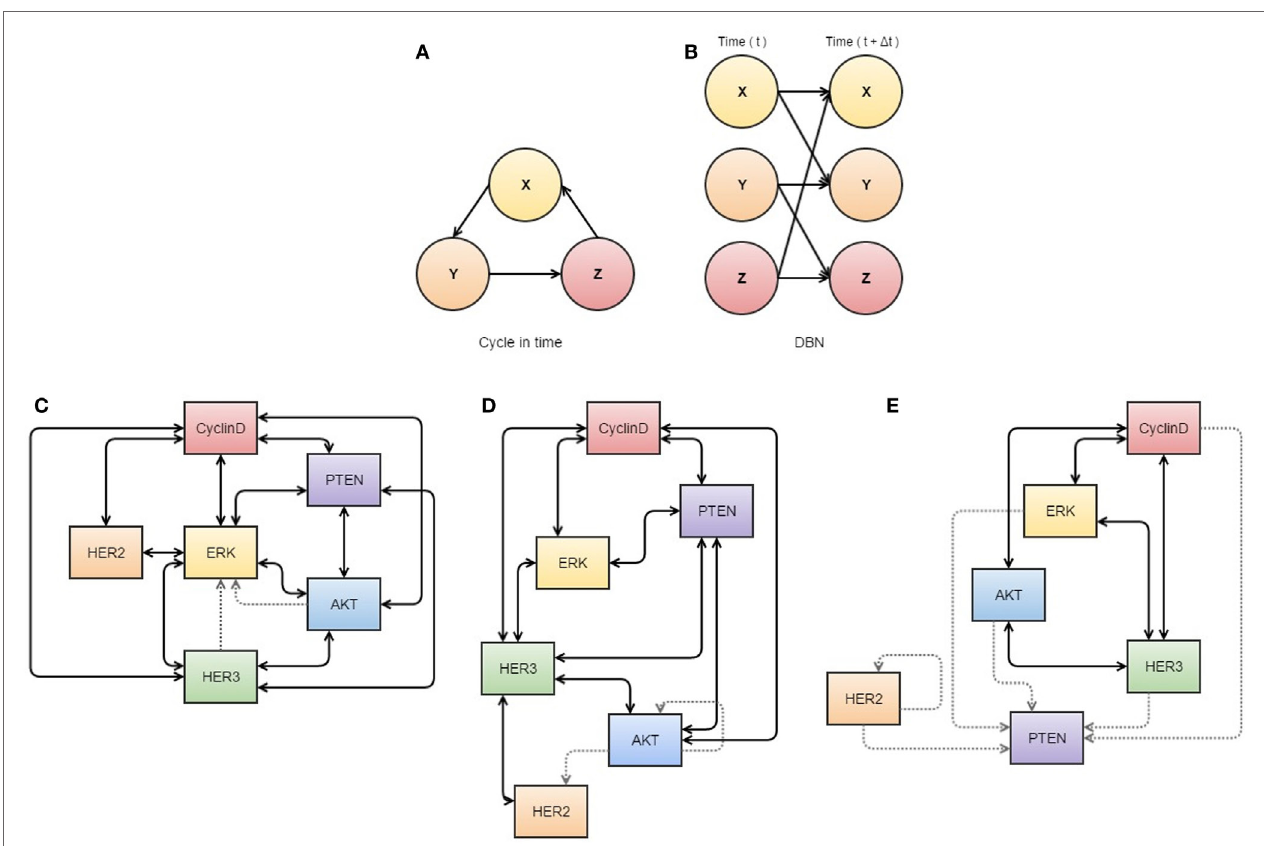
FiGURe 2 | Neural networks used in cancer systems biology . (A,B) illustrate the use of dynamic Bayesian networks. (A) describes how events interact in a cyclic causal manner, as displayed in a dynamic Bayesian network (B) that represents all variables at two time points, allowing inference of causal relationships. (C–e) are visualizations of S-systems’ analyses. The data represents breast cancer cells treated with heregulin concurrently with pertuzumab (a HER2 inhibitor). The thickness of the lines indicates the strength of the interaction. (C) represents the first three time points at which data was obtained, (D) the next three overlapping time points, and (e) a further three overlapping time points. These diagrams may assist analysis of interactions in the network, as they appear to show dissociation of HER2 in response to treatment with its inhibitor. All components of this figure, including Bayesian networks and S-systems’ analysis, are adapted from the review by Faratian et al.